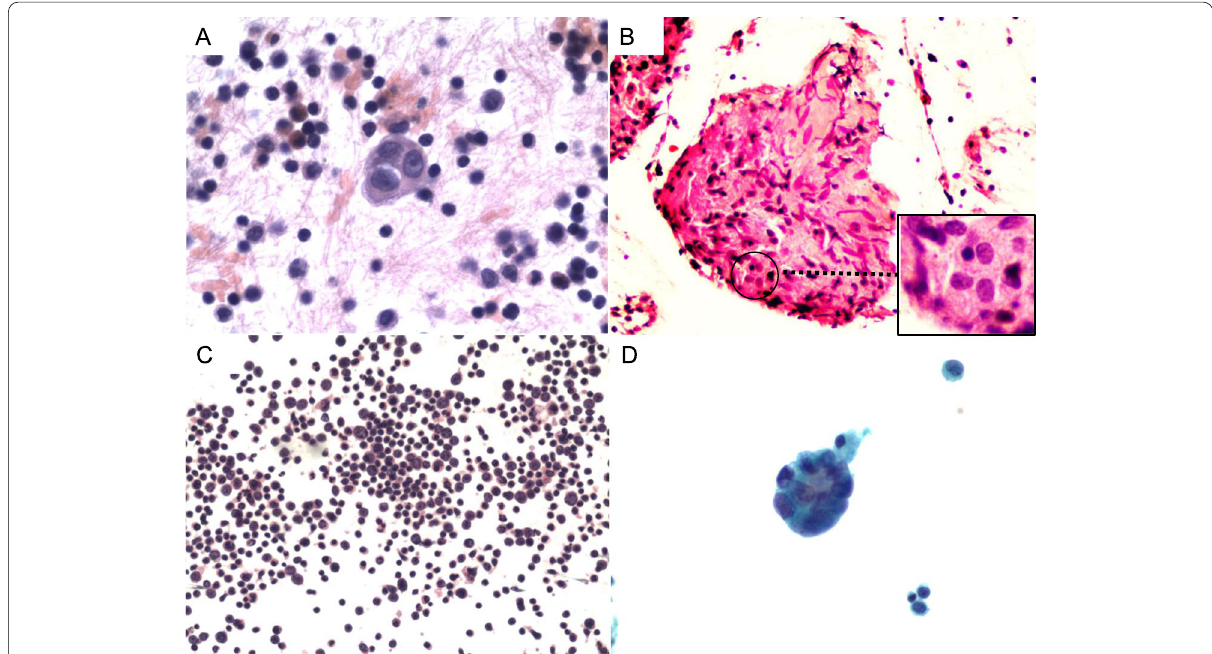
Fig. 1 False‑positive cases in pleural effusion specimens. Case 1: The cytological diagnosis was ‘SFM (IVa)’ ( A , HE, 400), while the histological × diagnosis was granulomatous lesions ( B , HE, 200). We think that the epithelioid cells in the granulomatous lesions (bottom right of the Figure B) × may have been mistaken for SFM. Case 2: The cytological diagnosis was ‘SFM (IVa)’ ( C , HE, 100), while the clinical diagnosis was ‘tuberculosis’. The × patient had a history of abdominal lymphoma. A few weeks after the cytological diagnosis, he was clinically diagnosed with thoracic tuberculosis, and the pleural fluid disappeared after anti‑tuberculosis treatment. The history of lymphoma may have led to our incorrect diagnosis. Case 3: The cytological diagnosis was ‘SFM (IVa)’ ( D , Papanicolaou stain, 400), while the clinical diagnosis was ‘chylothorax’. The misdiagnosed cells may be × reactive mesothelial cells caused by chylothorax